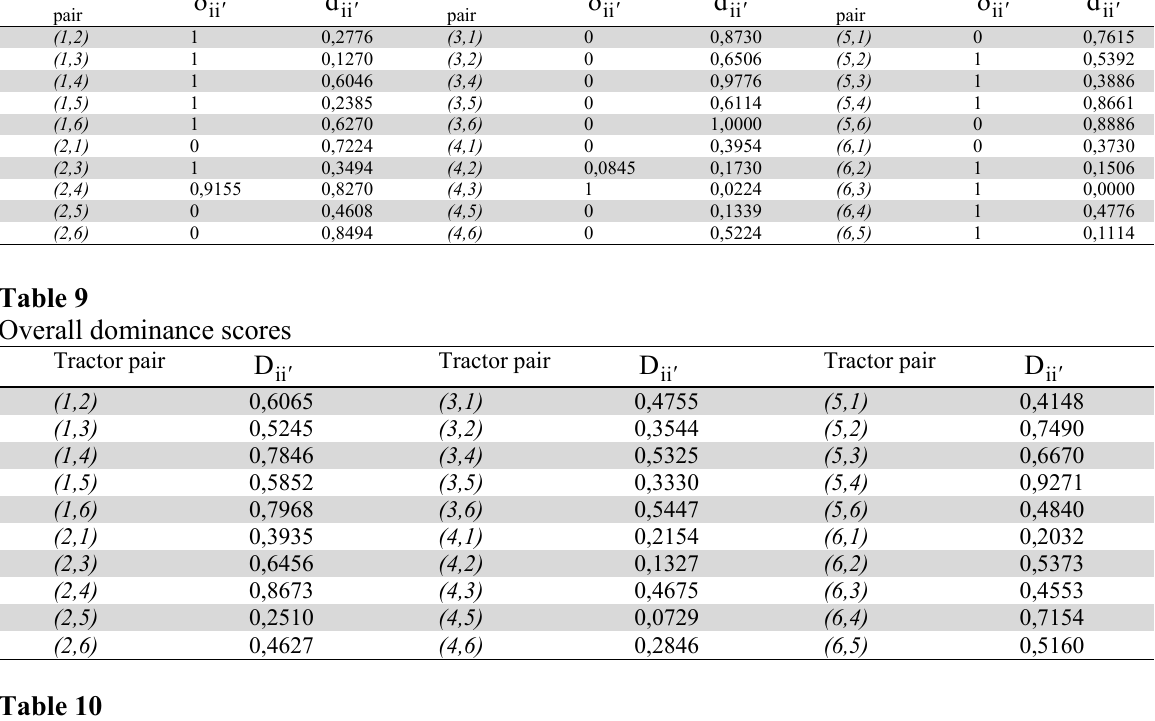
The standardized dominance scores Tractor pair